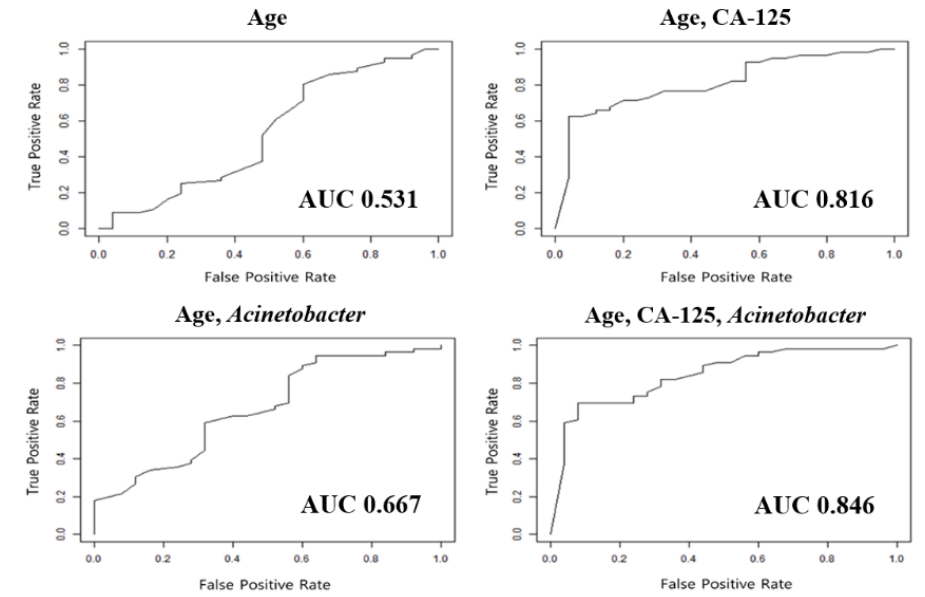
Figure 3. Comparisons of performances among diagnostic models differentiating ovarian cancer from benign ovarian tumors.